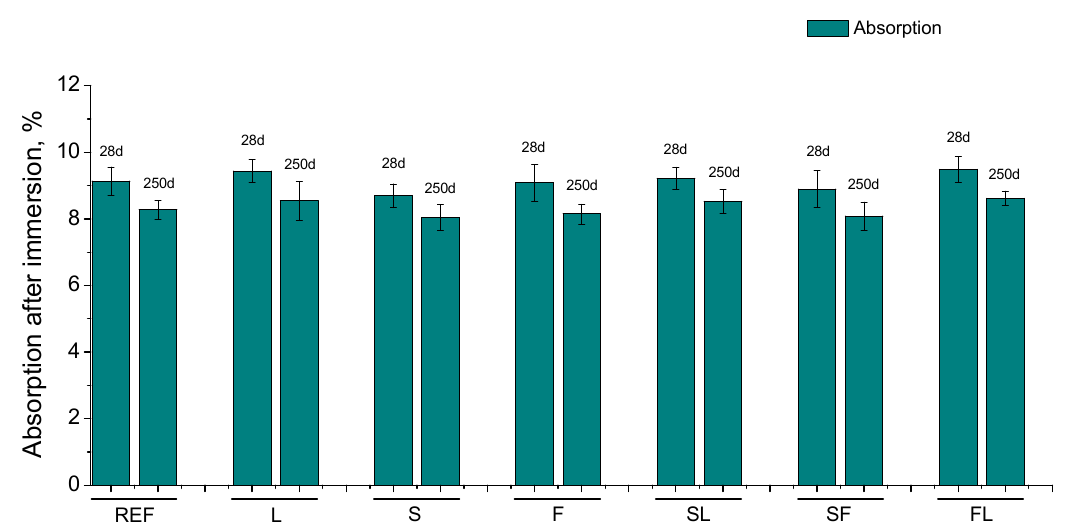
Figure 4. Results of absorption after immersion noted for the studied series.